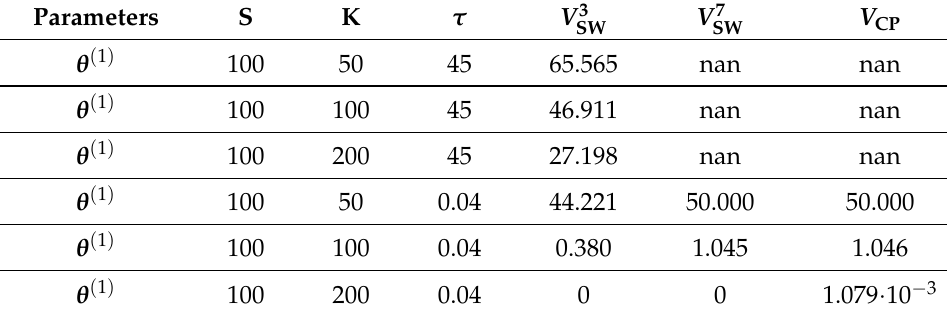
Table 2. Set of Heston parameters used in the numerical